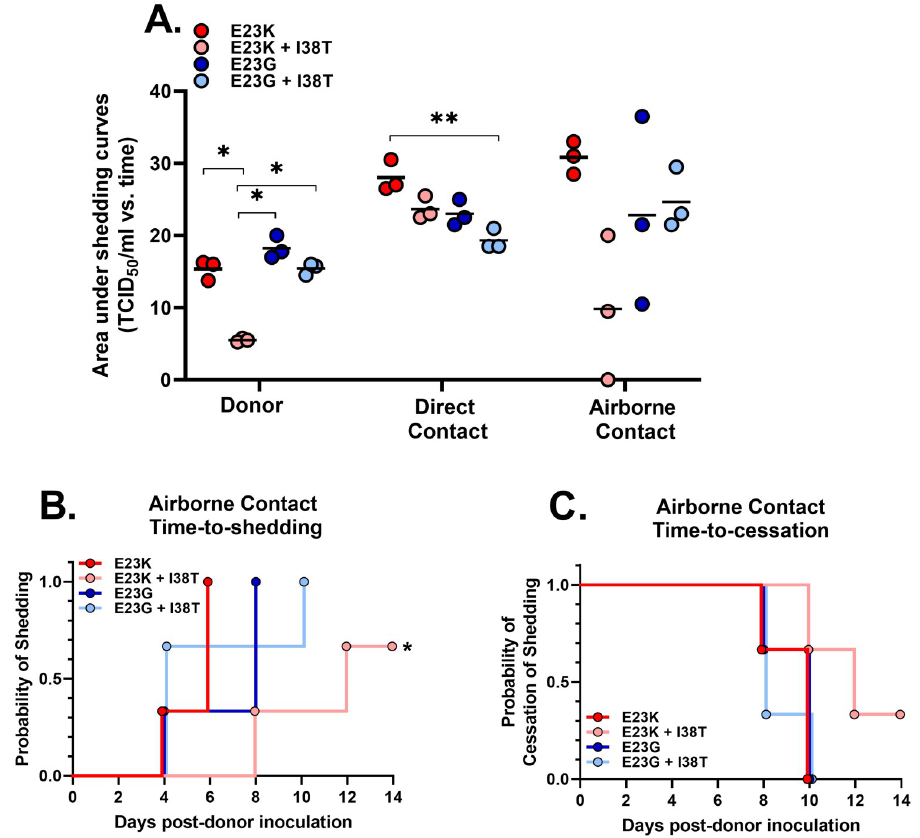
Fig 3. Shedding parameters of PA E23G/K influenza A viruses in ferrets. A) The nasal washes described in Fig 2 were subjected to area-under-the-curve (AUC) analysis by contact type. � P � 0.03, �� P � 0.01 B, C) Airborne contact nasal sampling was analyzed by Kaplan–Meier curves and the log-rank test to estimate the time-to-events, including the onset of shedding and the cessation of shedding. � P < 0.03 vs. E23K.